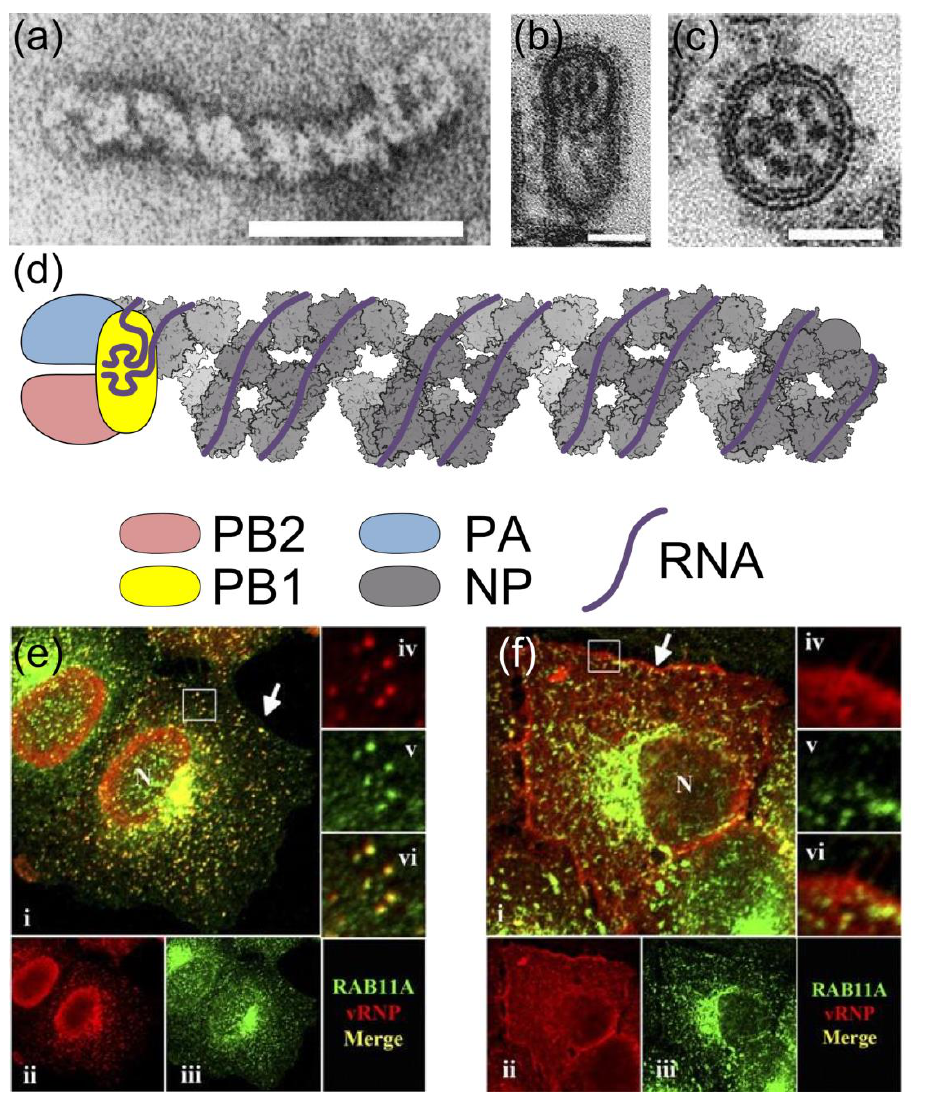
Figure 1. The influenza A virus ribonucleoprotein (RNP). The negative-sense RNA of the influenza A virus genome is divided into eight segments, each of which is encapsidated into an RNP. Electron micrographs showing ( a ) a negatively-stained RNP and ( b ) longitudinal and ( c ) transverse views of budding virions; scale bars are 50 nm. In ( b ) and ( c ) a complex of eight RNPs is visible as dark rods or dots. ( d ) Diagram of RNP structure. The NP backbone is based on reference [9] (PDB 4BBL, illustrated using the Python Molecular Viewer [14]); the polymerase and viral RNA, including the terminal promoter structure bound by PB1, are shown schematically. ( e , f ) Localisation of RNPs in an infected cell. Infected cells were fixed at 7 h ( e ) or 11 h ( f ) post-infection, and labelled with antibodies against RNPs (red, ii and iv ) and the Rab11 isoform Rab11A (green, iii and v ). The selected regions are enlarged 3× in frames iv , v and vi . As the infection progresses RNPs are exported from the nucleus (N) and associate with Rab11 in a perinuclear region for transport across the cytoplasm, then dissociate from Rab11 at the plasma membrane (arrow). Images in ( a ) reprinted from [15] with permission from Elsevier; in ( b , c ) adapted by permission from Macmillan Publishers Ltd: Nature [16], copyright (2006) and in ( e , f ) reproduced from [17] with permission from American Society for